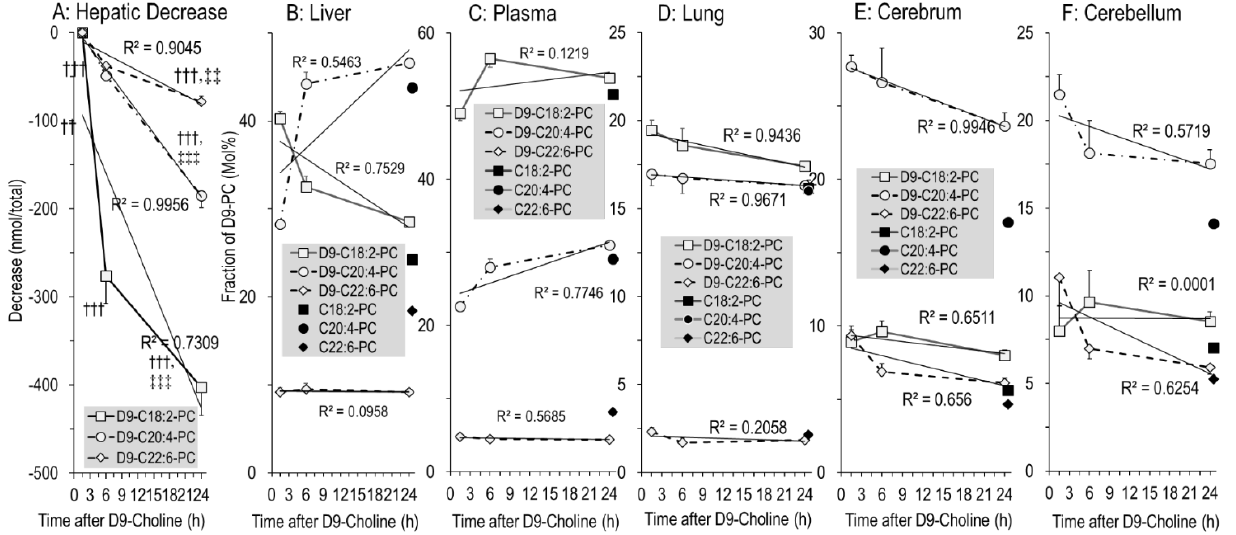
Figure 6. The absolute decrease in poly-unsaturated D9-labeled PC subgroups in the liver ( A ), and their fractions in D9-labeled versus endogenous PC in the liver ( B ), plasma ( C ), lung ( D ), cerebrum ( E ) and cerebellum ( F ). C18:2-PC ( ■ ), C20:4-PC ( ● ) and C22:6-PC ( ) represent the endogenous PC sub-groups containing a linoleic (C18:2n-6), arachidonic (C20:4n-6) or docosahexaenoic (C22:6n-3) acid residue, respectively, of all time points (N = 27), whereas their D9-choline-labeled analogues are indicated by open symbols (D9-C18:2-PC [ □ ] , D9-C20:4-PC [ ○] and D9-C22:6-PC [ ], respec- tively). Dataare means ± SE at the respective time points (N = 8 – 10). ††, p < 0.01, †††, p < 0.001 vs. 1.5 (cid:35)